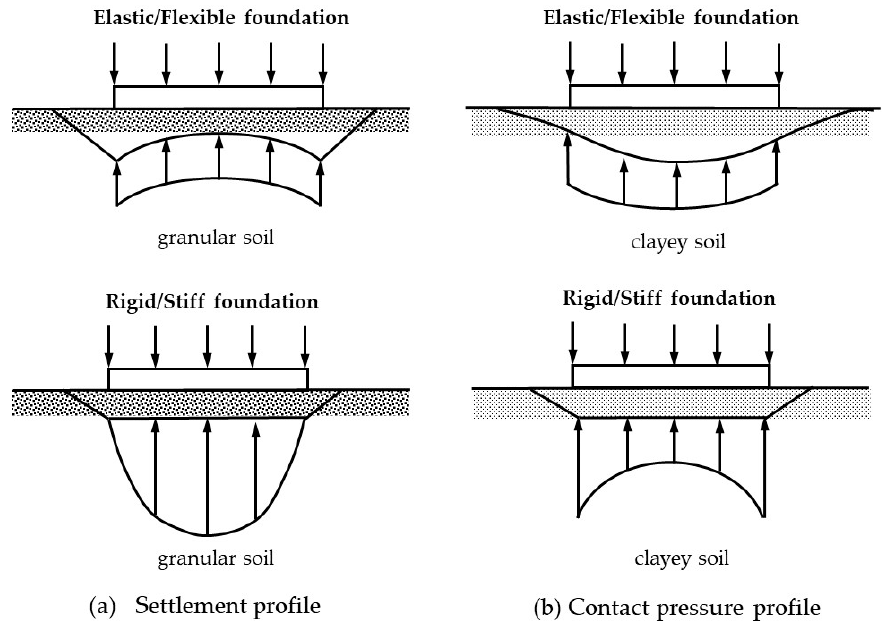
Figure 1. Assumed distributions of foundation settlements and contact pressures for structural design analysis of foundations.